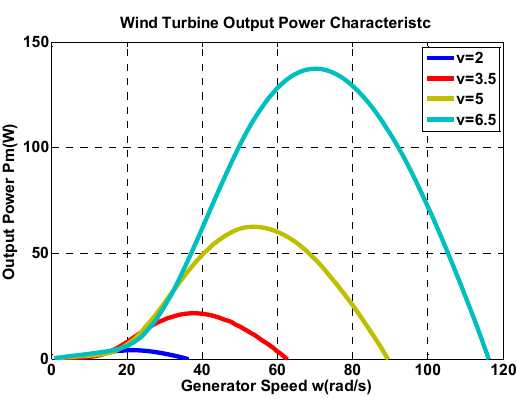
Figure 2. Power characteristic